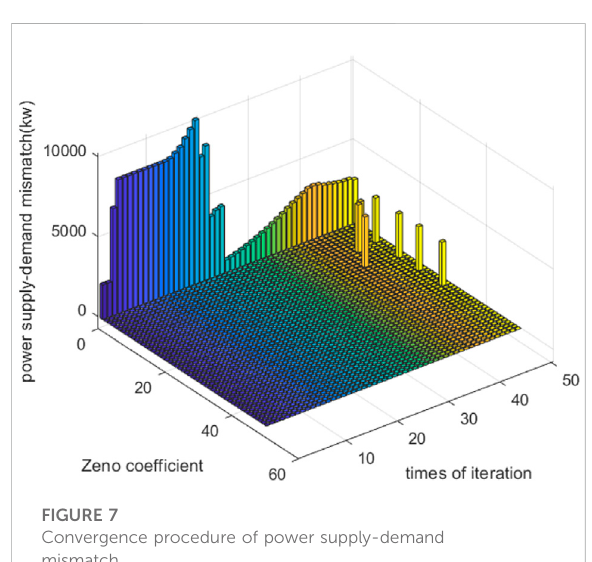
FIGURE 5 Convergence procedure of heat price.